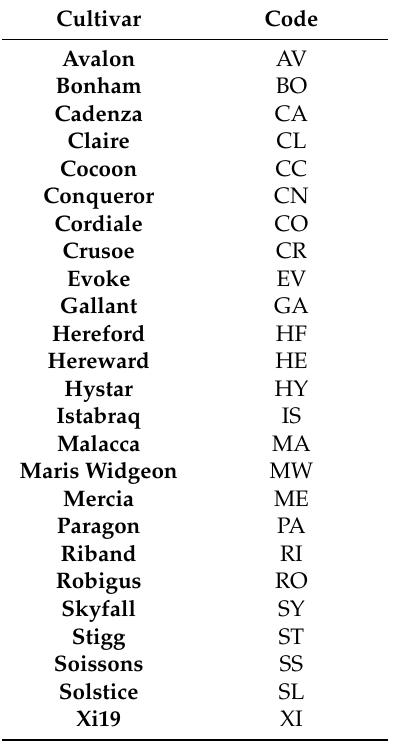
Table 2. Codes for each cultivar of wheat crop grown in the diversity field